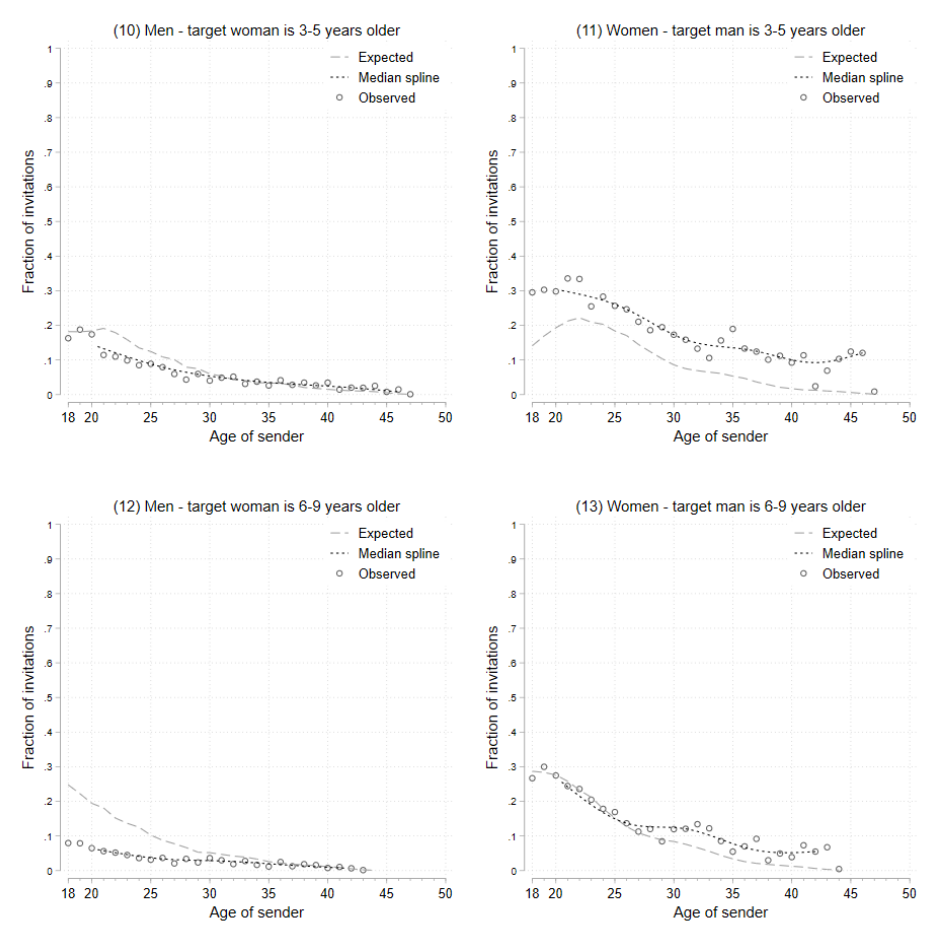
to older younger